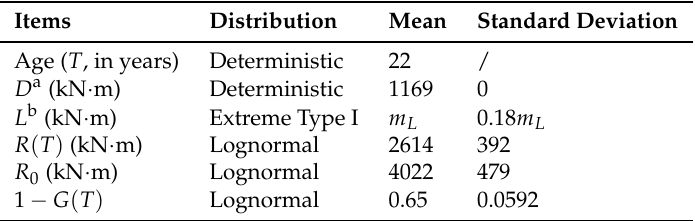
Table 1. Parameters of Qingfang Bridge and their distributions. Items Distribution Mean